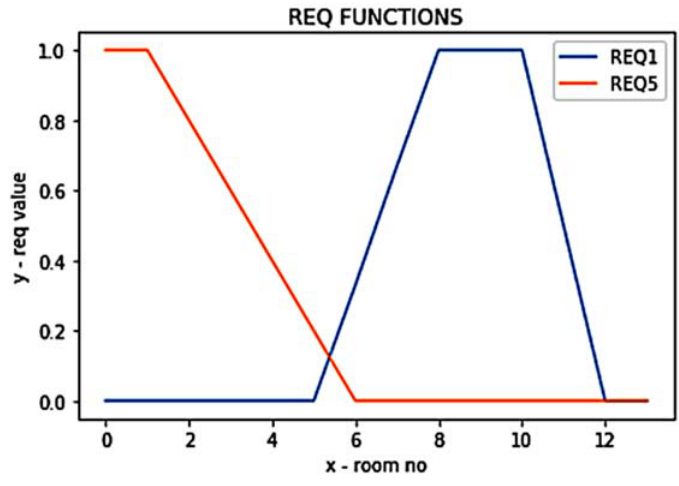
Figure 7. Requirement (REQ1 and REQ5) evaluation functions.